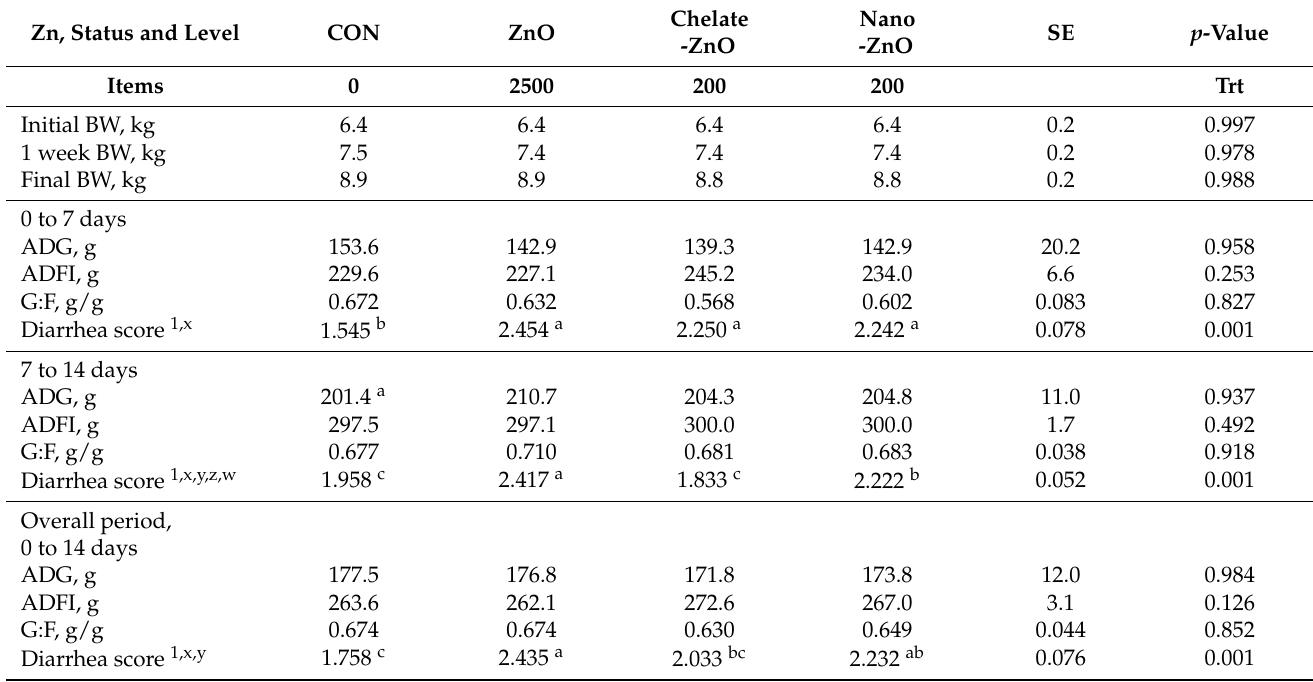
Table 3. Effects of different forms of dietary zinc oxide on the growth performance and diarrhea score of weaned piglets ( n =